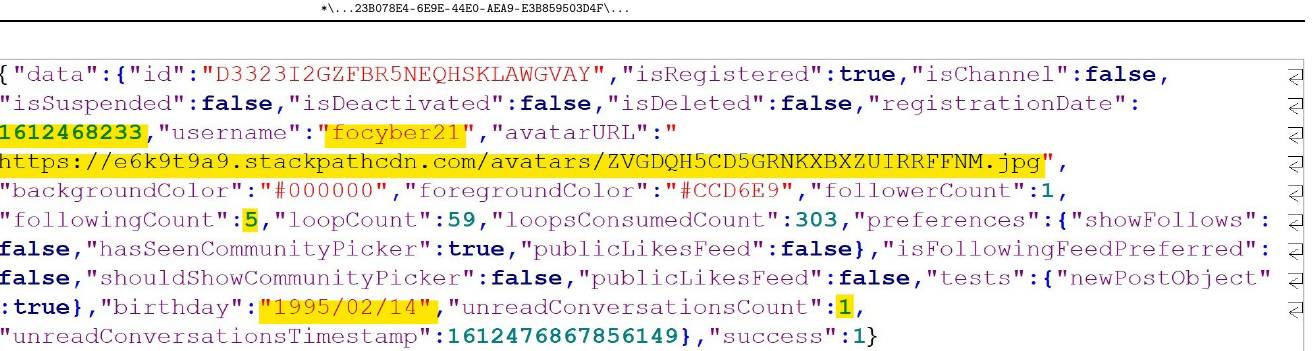
Figure 7. focyber21 information recovered from Byte app as shown in DB Browser for